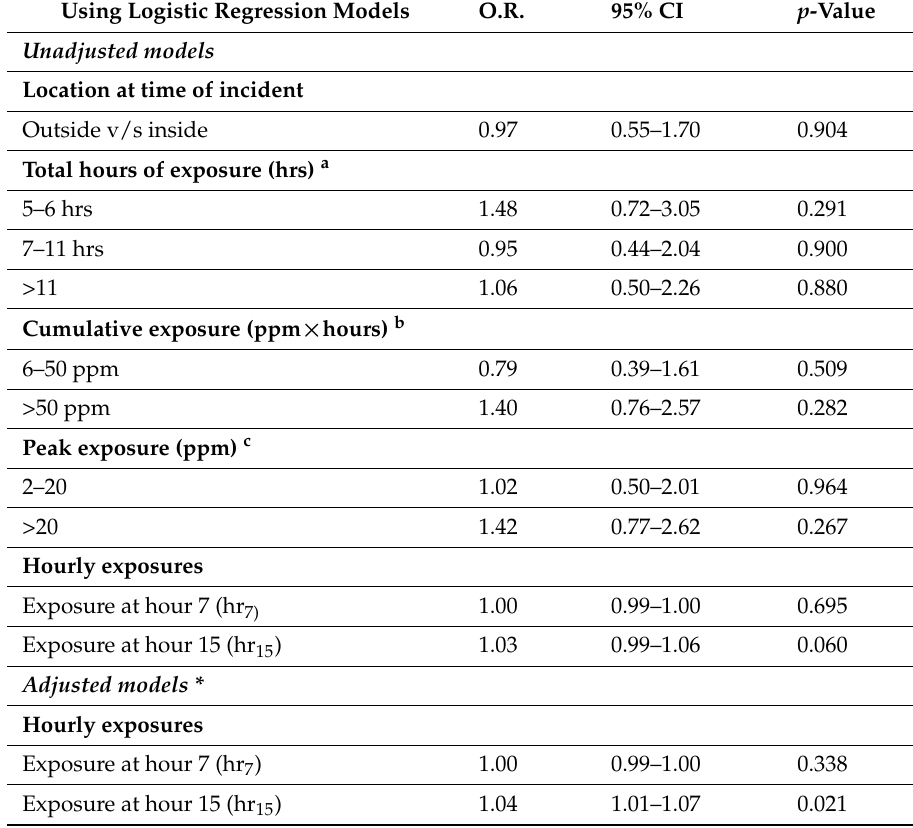
Table 5. Relationship between environmental factors associated with persistent lower respiratory symptoms/asthma in subjects exposed to the sulphur stockpile fire